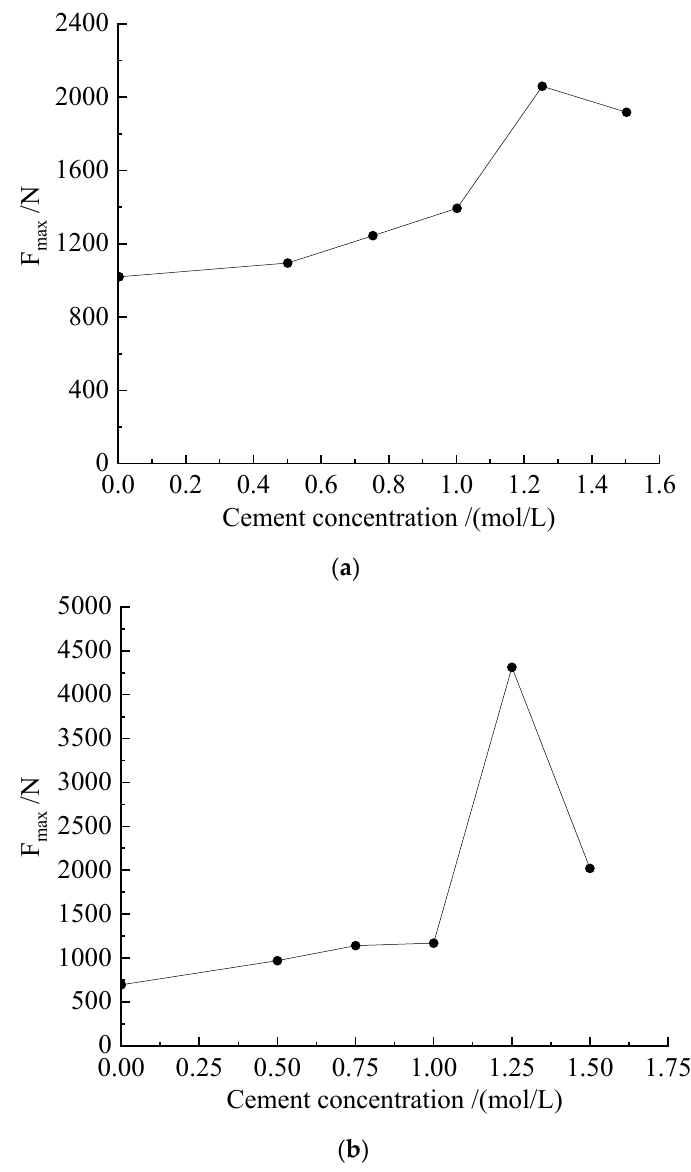
Figure 5. Axial force (F max )–concentration curves of different samples in scheme M. ( a ) Axial force (F max )–concentration curve of cementation solution of constant-temperature sample in M scheme. ( b ) Axial force (F max )–concentration curve of cementation solution for soaked samples in scheme M.